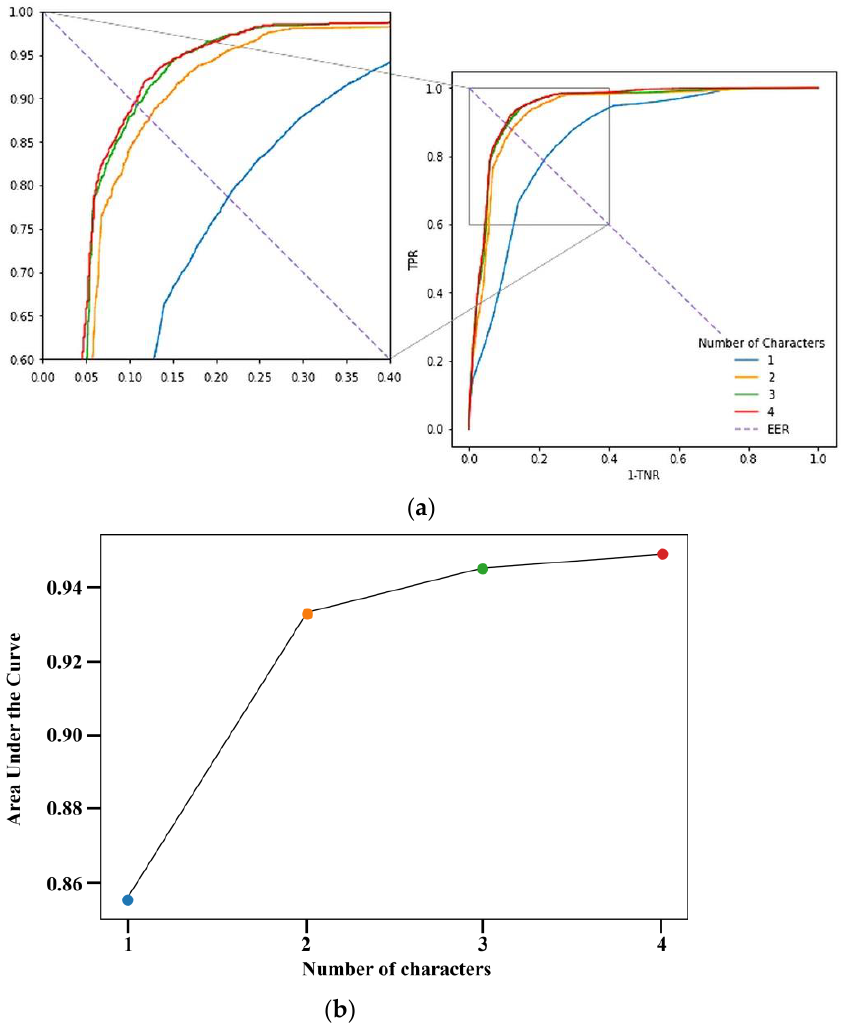
Figure 9. An example of receiver operating characteristic curve (ROC) and AUC: ( a ) ROC curve; ( b ) AUC by number of characters.